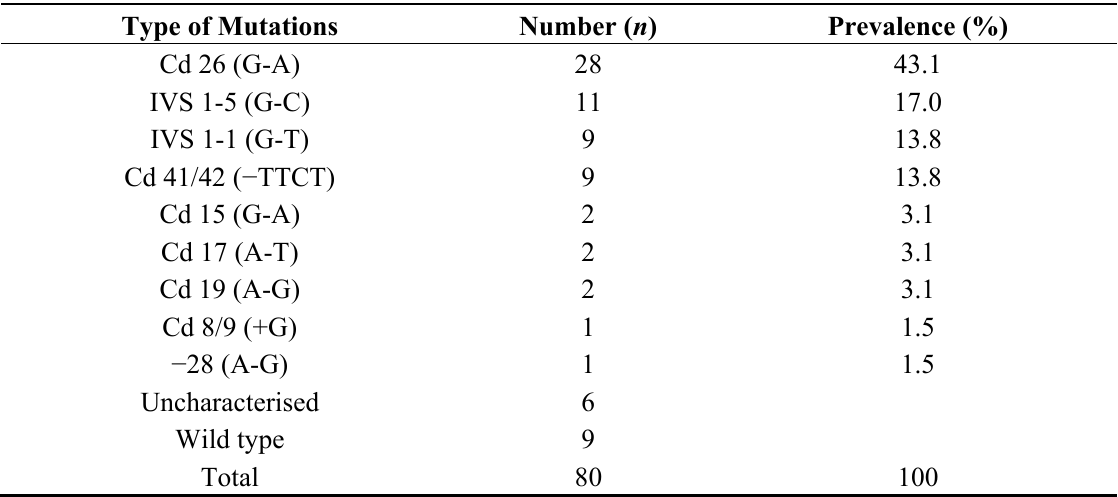
Table 4. Distribution of β -thalassaemia mutations identified in Malay patients.